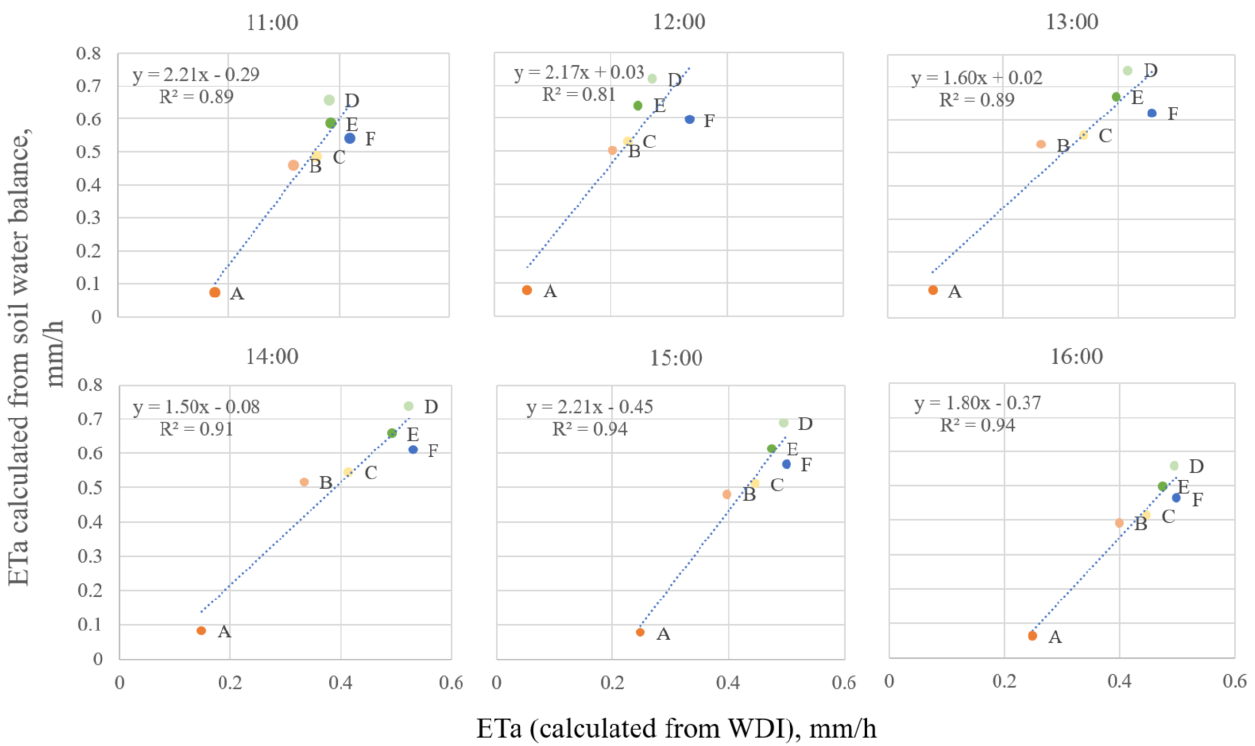
Figure 11. Correlation between ET a (mm h −1 ) calculated from WDI NDVI and ET a (mm h −1 ) calculated from soil water balance during the day of 23 April 2020. The treatment names A–F refer to treatments from the lowest to the highest irrigation amounts, respectively.